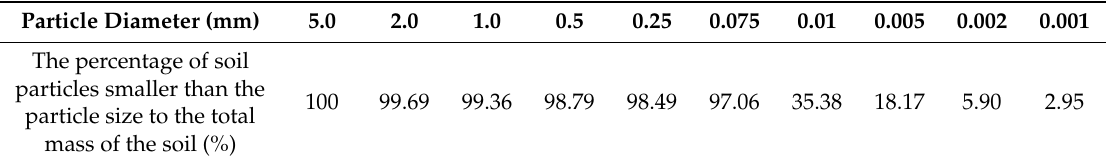
Table 1. Particle analysis test results of silty soil.